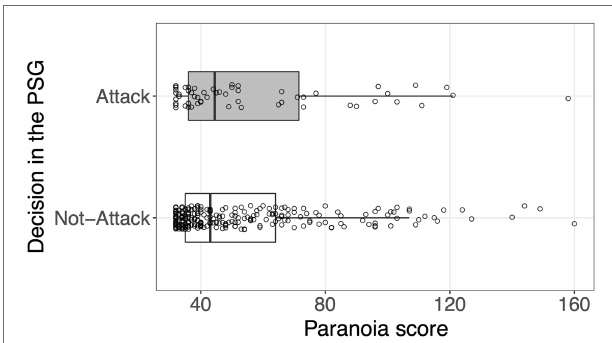
FIGURE 3 | Distributions of the paranoia score in relation to the decision made in the PSG. Each point represents each participant. Boxplots indicate the distributions of the paranoia score. The box, the thick line in each box, and the whisker represent the IQR, the median, and the distances 1.5 × IQR, respectively. Random vertical jitter was added to each point for ease of